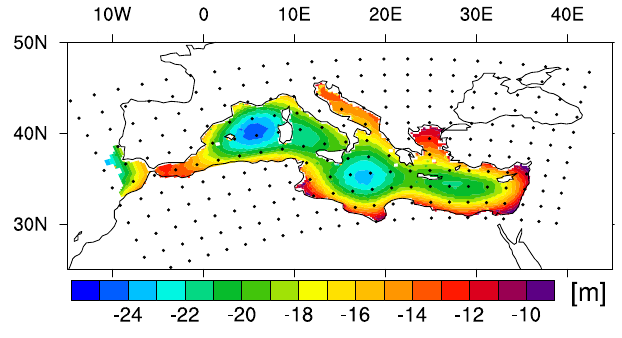
Fig. 1. Topography changes between 9K and CTRL. The superim- posed dots represent 1 of each 10 grid box centre of the model in each